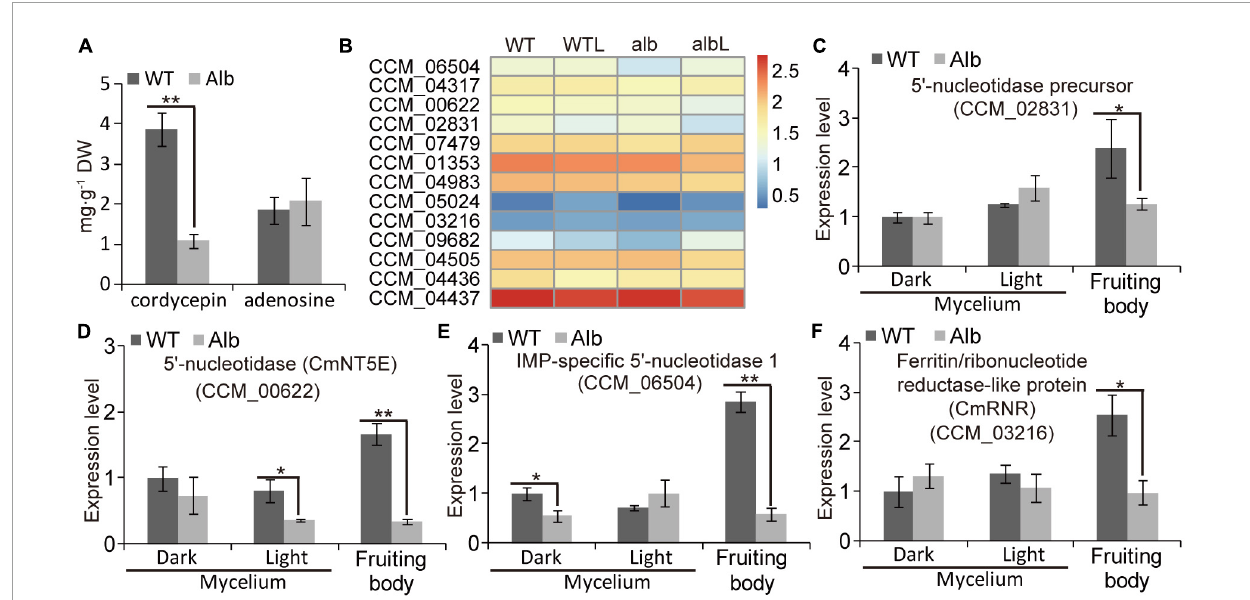
FIGURE8 Expression analysis of genes related cordycepin biosynthesis. (A) Compare of cordycepin and adenosine contents in the fruiting body of WT and Alb ; (B) heatmap analysis of CCM_06504, CCM_04317, CmNT5E (CCM_00622), CCM_02831, CCM_007479, CCM_01353, CCM_04983, CCM_05024, CCM_03216, CCM_09682, CCM_04505, CCM_04436, and CCM_04437 based on their FPKM values in the WT, WTL, Alb , and AlbL samples; (C–F) expression analysis of CCM_02831, CmNT5E (CCM_00622), CCM_06504, and CCM_03216 in the mycelia under dark and light treatment,